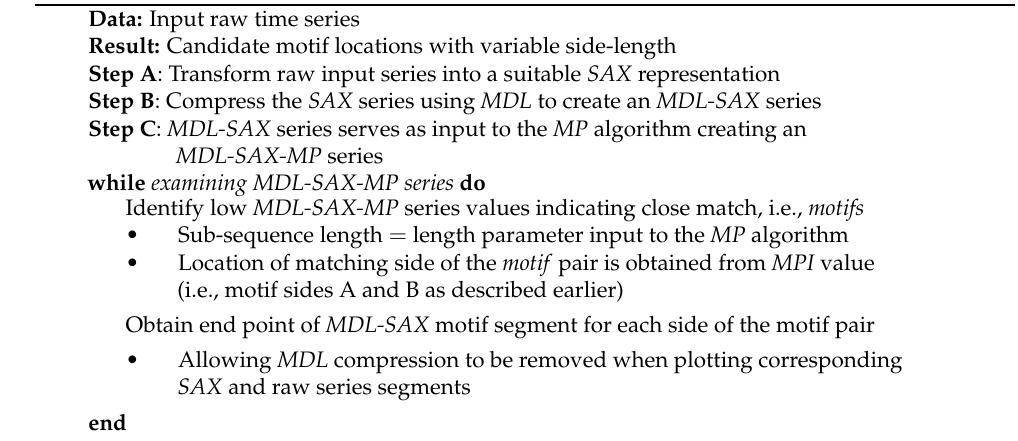
Algorithm 1: S ide- L ength- I ndependent M otif ( SLIM ) pseudo-code. Data: Input raw time